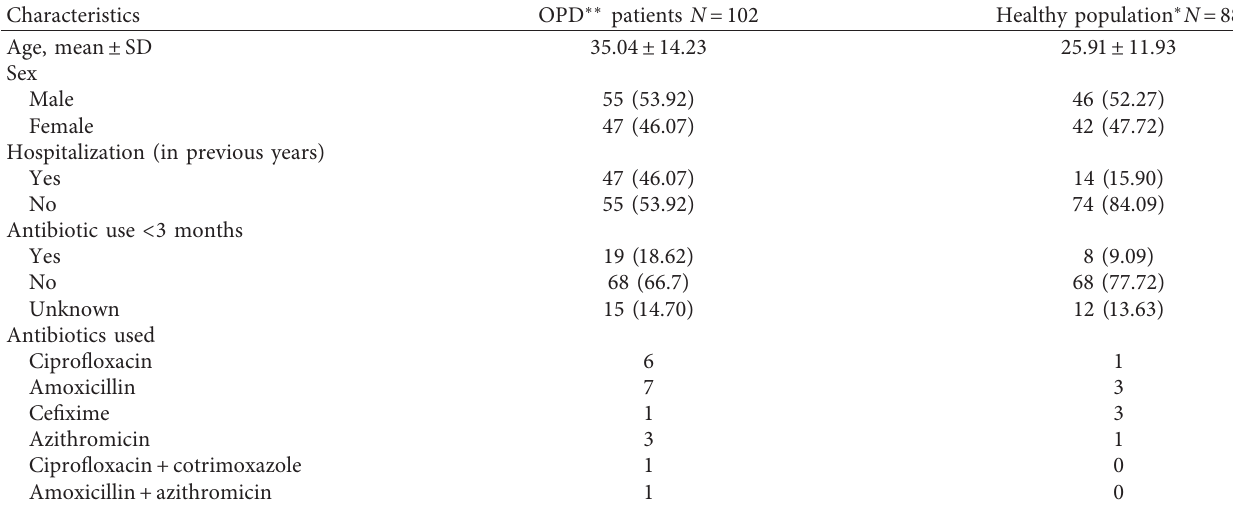
Table 1: Characteristics of the study population.